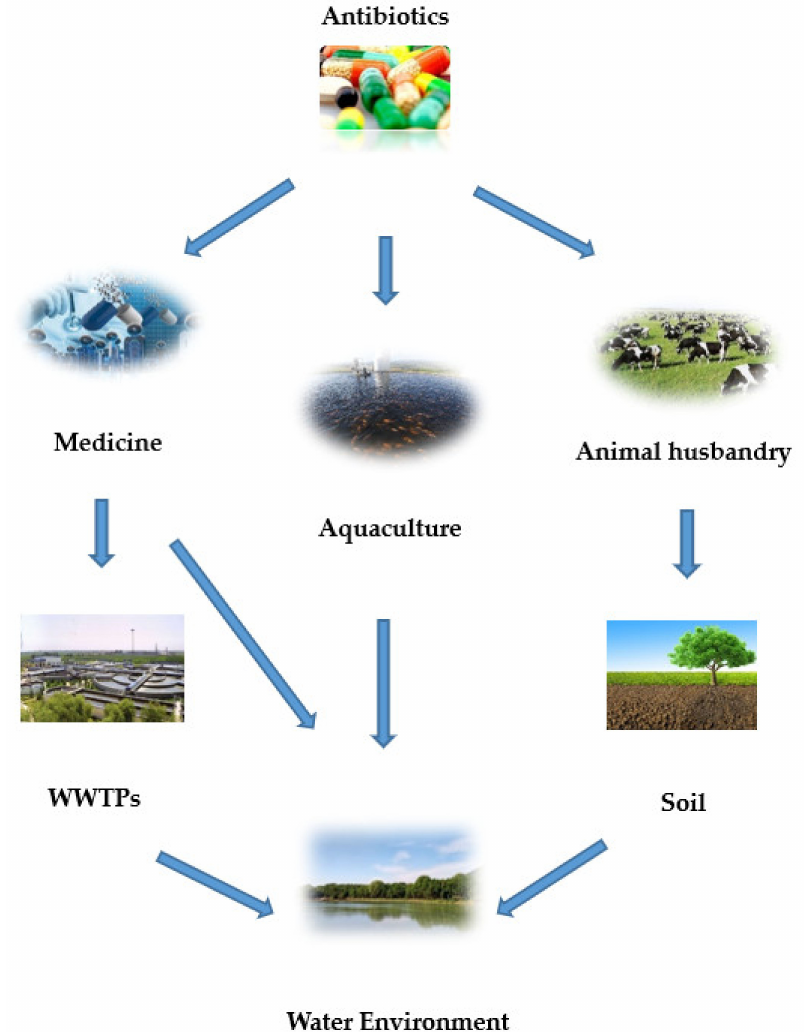
Figure 1. Sources of antibiotics in the water